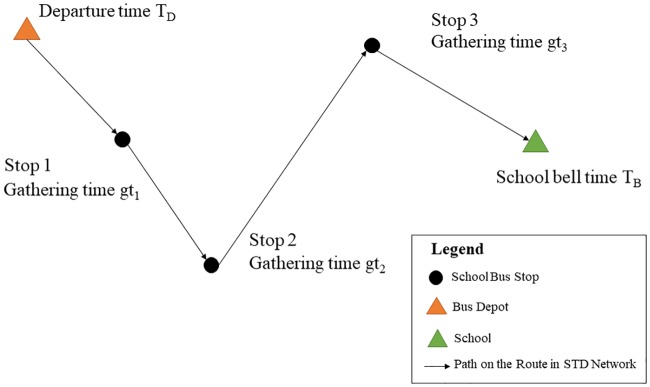
An example of the school bus route.